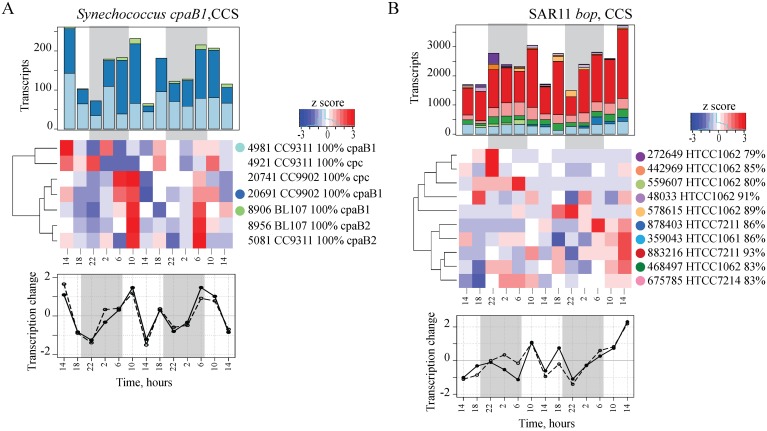
OTU-Specific Daily Gene Transcription Patterns by Synechococcus and SAR11 in the CCS.Periodic transcription of phycoerythrin type I cpaB1 gene (A) varied among Synechococcus OTUs. Transcription of the bop gene varied among the SAR11 OTUs (B). Top panels: Transcriptional composition detected based on the MAGC approach, where transcription was normalized to the total Synechococcus (A) and SAR11 (B) hits in each sample, over time of day (X-axis in hours). OTUs are color-coded according to the heatmap. Middle panels: Hierarchical clustering of transcription patterns (by Pearson correlation). The heatmap for Synechococcus gene-OTUs (A) also shows transcriptional patterns for phycoerythrin type II pcaB2 and phycocyanin cpc genes. Each row in the heatmap shows transcription pattern of a unique OTU, and each column is a time point within the time-series. Bottom panels: Temporal patterns of total transcript abundances detected by MAGC (open circle) in this study and by WGPB (closed circle) [11] shows that the results of the two approaches are consistent.